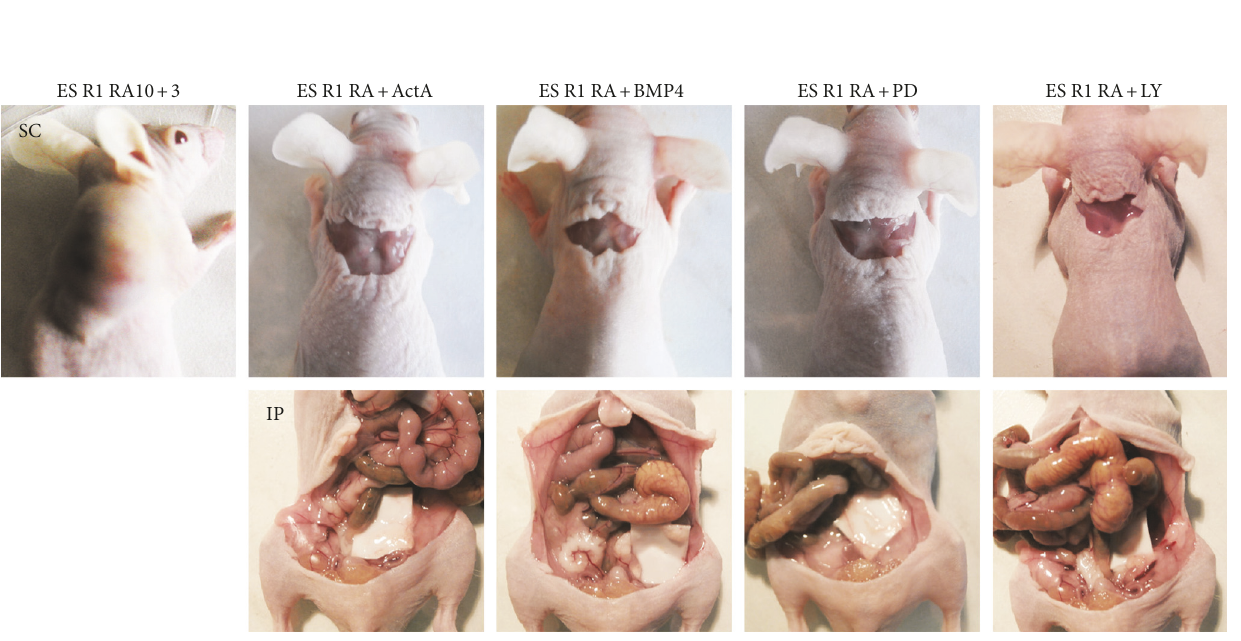
Figure 6: Assessment of the tumorigenic potential of ES R1 cells stimulated to di ff erentiate with RA, Activin A, BMP4, PD98059, and LY294002 after transplantation into nude mice. No tumors were detected in nude mice after subcutaneous (SC) and intraperitoneal (IP) transplantation of ES R1 cells on day 3 after RA and additive withdrawal. Teratomas formed only after subcutaneous transplantation of ES R1 cells on day 3 after RA withdrawal (ES R1 RA10+3). ActA: Activin A; BMP: BMP4; PD: PD98059; LY: LY294002.